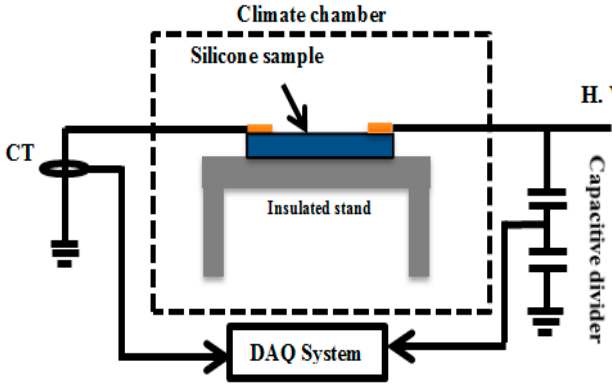
Figure 1. The high ‐ voltage test setup.